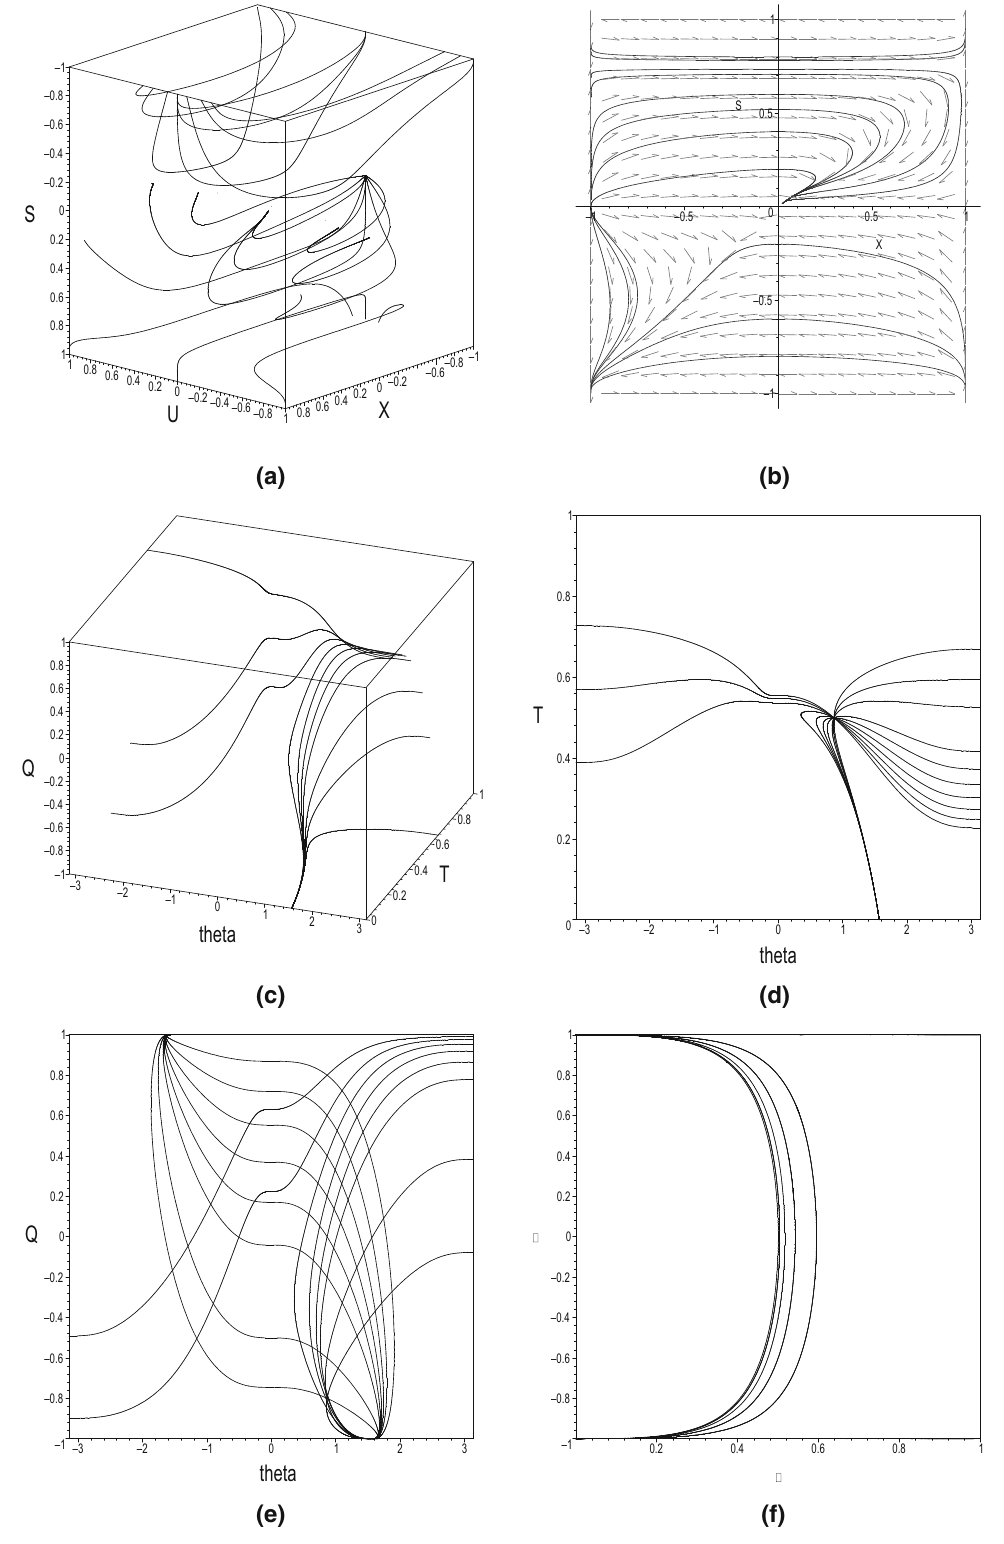
Fig. 11 a Compact phase portrait of (249), (250), (251) for the choice n = 2 ,μ = 1. b Dynamics in the invariant set Z = 0. c – f Dynamics of (272), (273), (274) and some 2D projections of the solutions for n = 4 ,μ =